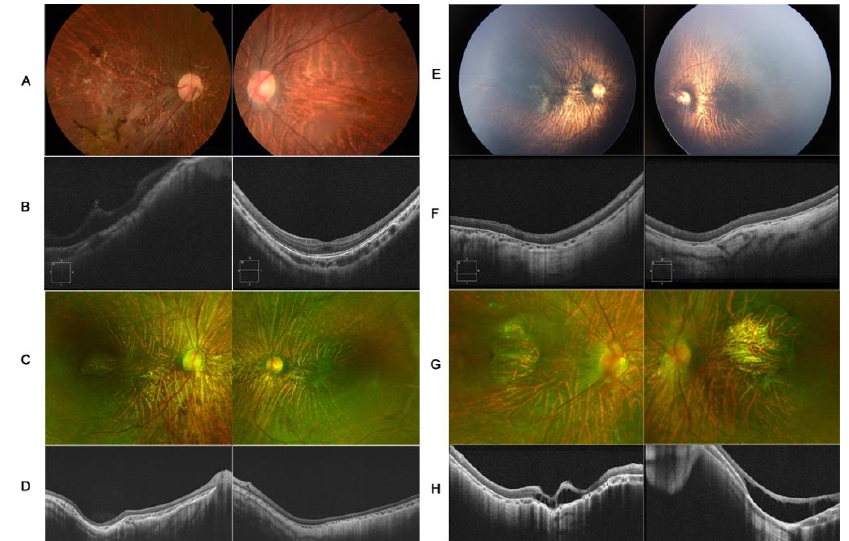
Figure 1. Fundus photographs and macular coherence tomography (OCT) images in patient 1 ( A , B ), patient 2 ( C , D ), patient 3 ( E , F ), and patient 4 ( G , H ). ( A ) Fundus photography showed tessellated fundus in patient 1. The increased pigmentation in the right eye was induced by a history of retinal detachment. ( B ) OCT revealed mild hypoplasia in the left eye. ( C ) SLO showed tessellated fundus appearance, prominent choroidal, and punched-out macular in patient 2. ( D ) OCT revealed undetected macular and posterior staphyloma. ( E ) Fundus images showed tessellated fundus and prominent choroidal in patient 3. ( F ) OCT revealed undetected macular and posterior staphyloma. ( G )